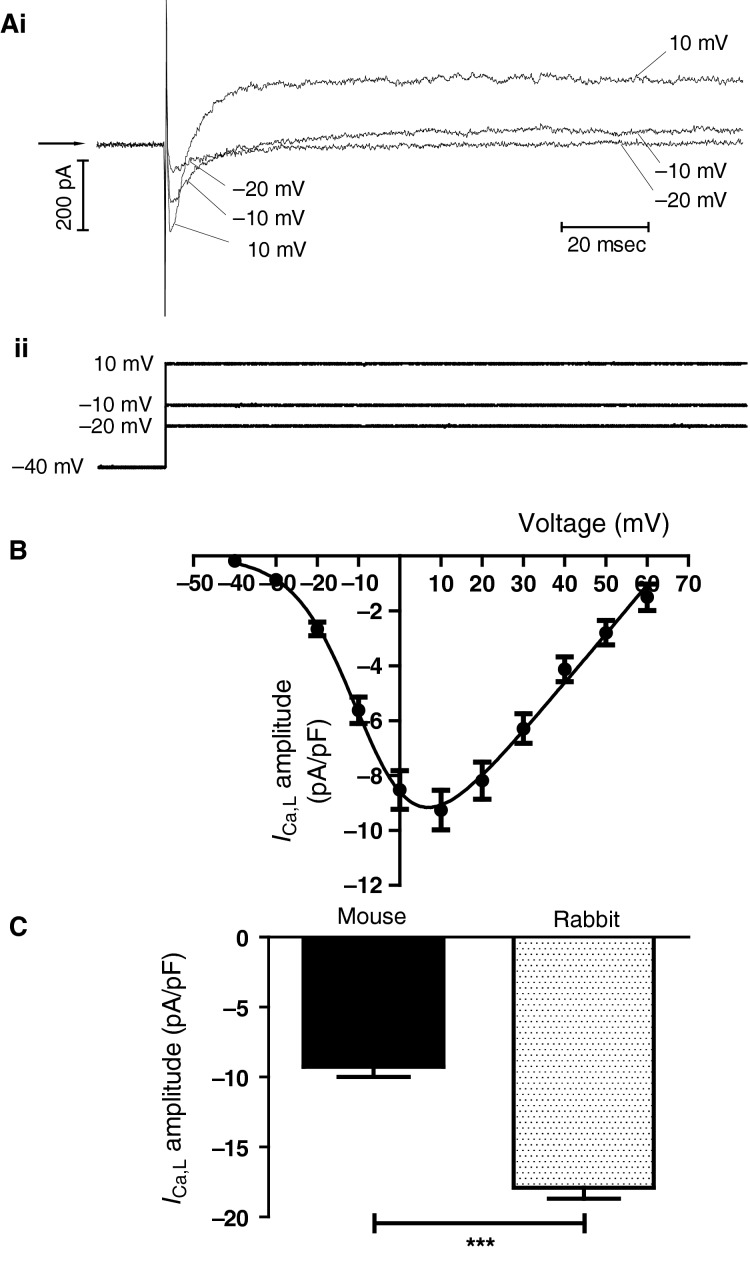
ICa,L. (A) Representative records (upper traces, i) for ICa,L elicited at −20, −10 and +10 mV from a holding potential of −40 mV, by protocol shown in lower traces (ii). (B) I–V relation for ICa,L (n = 24). Data were fitted with equation 1 in the Materials and Methods, to give a V0.5 of −7.6 ± 1.2 mV and a slope factor (k) of 7.6 ± 0.9 mV. Note that there was no significant difference of ICa,L amplitude between cells containing or lacking If (see Results text for peak density at +10 mV comparison) and so data were pooled. (C) Comparison of current density (pA/pF) of ICa,L at +10 mV in mouse (n = 24) and rabbit (n = 29) AVN cells. Asterisks denote statistical significance at ***P < 0.0001 (unpaired t-test).